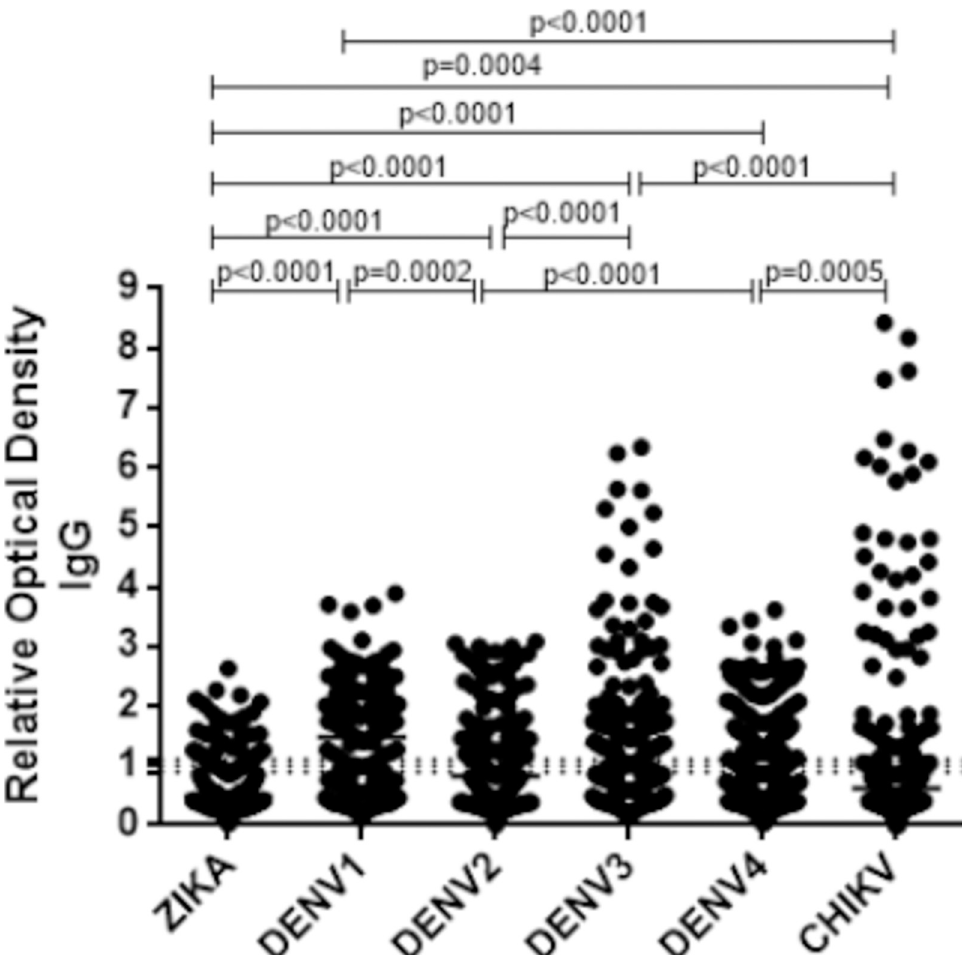
Fig 1. Evaluation of the relative optical density of anti-NS1 IgG from Zika, Dengue (serotypes 1–4) and anti-E2 IgG from Chikungunya. The interval between the dotted lines are values between 0.9 and 1.1 that were considered